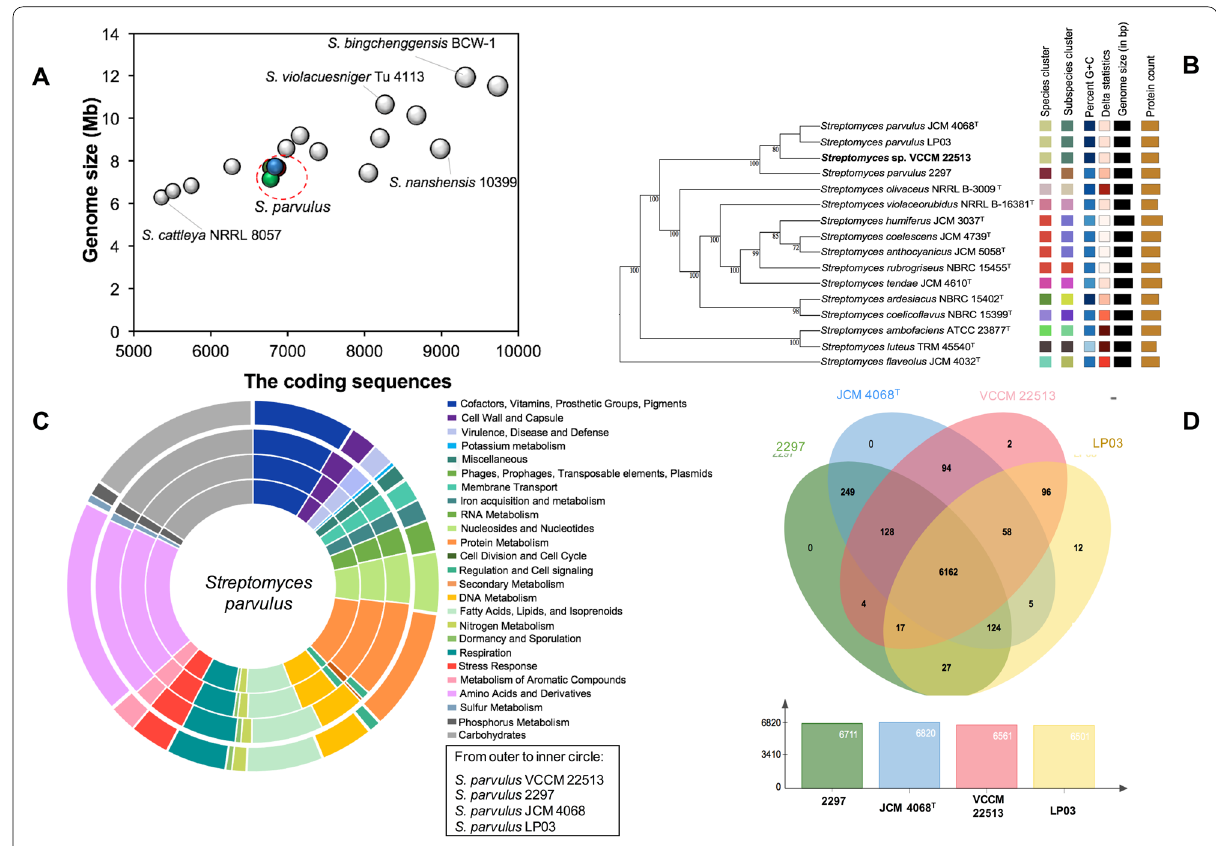
Fig. 2 Identification and genome‑wide comparison between S. parvulus VCCM 22513 and its relatives within the genus Streptomyces . A Comparison of genome size and number of CDS of 18 Streptomyces genomes with the focus on S. parvulus . B Whole genome‑based phylogenetic classification indicating Streptomyces sp. VCCM 22513 as a member of S. parvulus. C SEED Sub‑systems predicted in S. parvulus VCCM 22513 and 3 other S. parvulus genomes using RASTtk. D Venn diagram showing the number of shared and unique proteins between S. parvulus VCCM 22513 and other S. parvulus